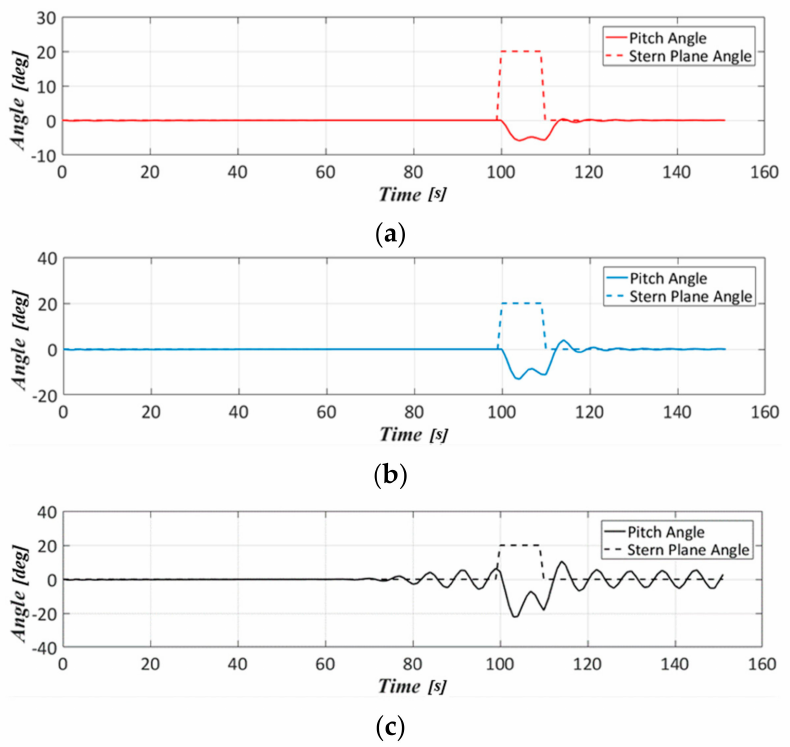
Figure 22. Comparisons of rudder and pitch angles at different sailing speeds. ( a ) U = 0.5, ( b ) U = 1, and ( c ) U = 1.5